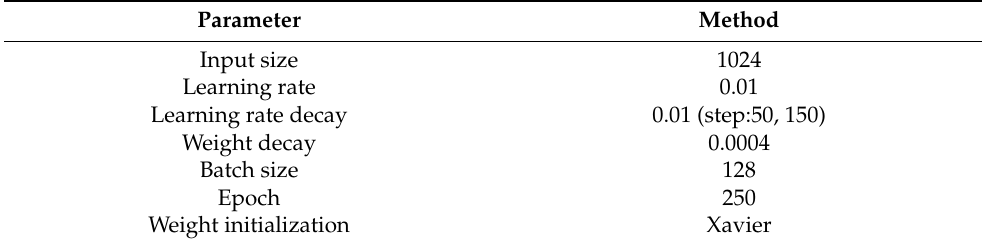
Figure 10. Typical images for six place classifiers. ( a ) are building, forest or mountain, and street. ( b ) are traffic, etc., and irrelevant [26]. Table 9. Training Parameters of place classifier